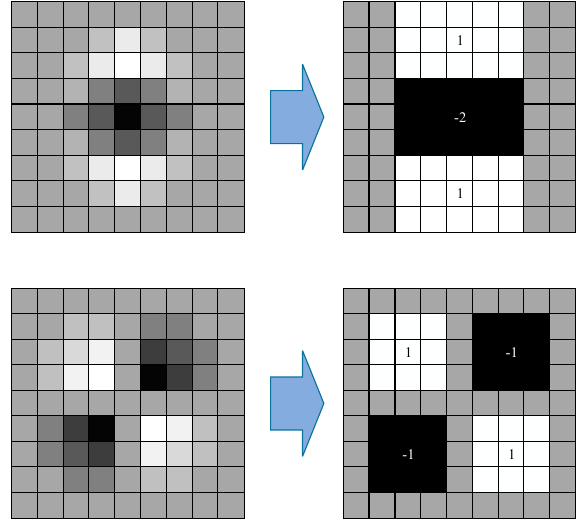
Figure 6. Box filter used to approximate the second-order Gaussian partial derivation.